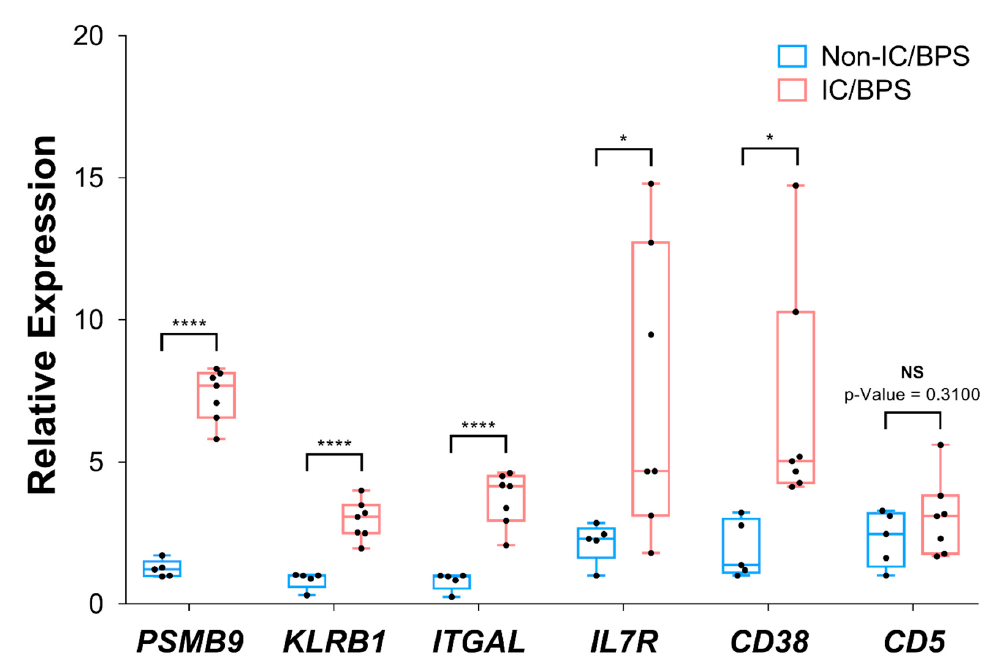
Figure 8. Relative mRNA expression of six hub genes was analyzed by RT-qPCR using non-IC/BPS ( n = 5) and IC / BPS ( n = 7) tissue samples. Expression of genes was normalized with GAPDH , ( n = 5) and IC/BPS ( n = 7) tissue samples. Expression of genes was normalized with GAPDH , a a housekeeping gene, expression. * p < 0.05, **** p < 0.0001, NS: housekeeping gene, expression. * p < 0.05, **** p < 0.0001, NS: non-significant.